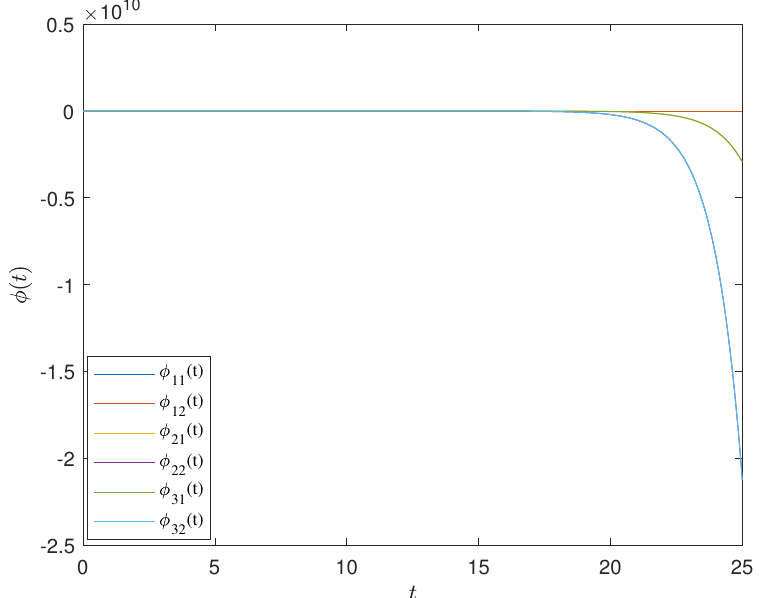
Figure 4. The trajectory of the system state without control input in Example 1. The trajectory of the system was unstable without any control.